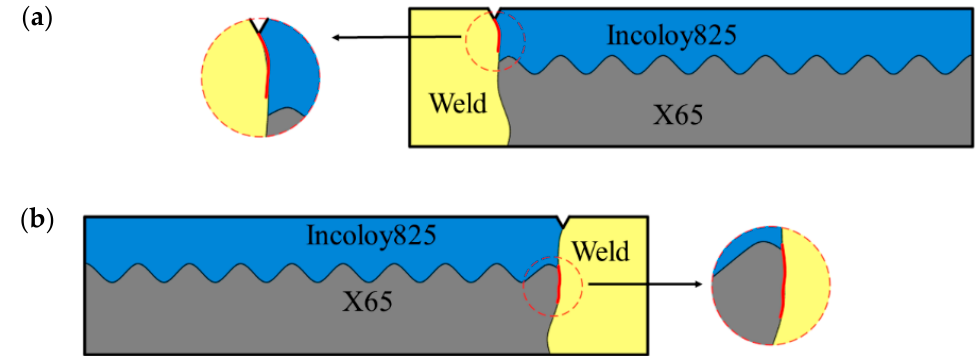
Figure 6. Schematic diagram of crack location: ( a ) crack 1; ( b ) crack 2.